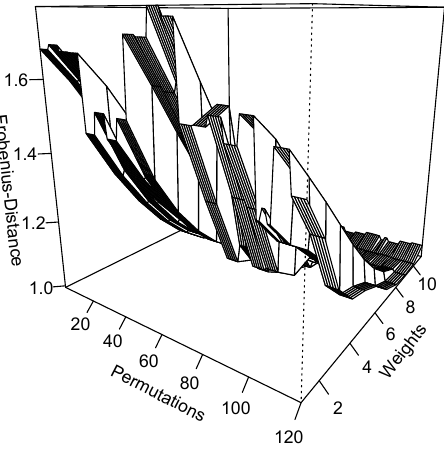
Figure 4. 3D plot: impact of permutations and weights on the Frobenius norm (with G 51 and H 51